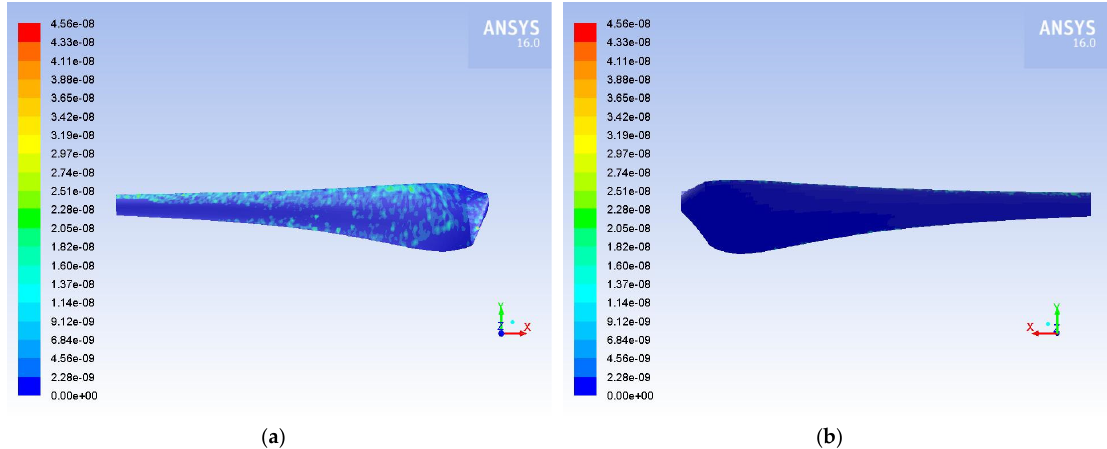
Figure 13. Erosion rate on the blade’s ( a ) pressure and ( b ) suction side, for wind speed of 15 m·s − 1 and Q =